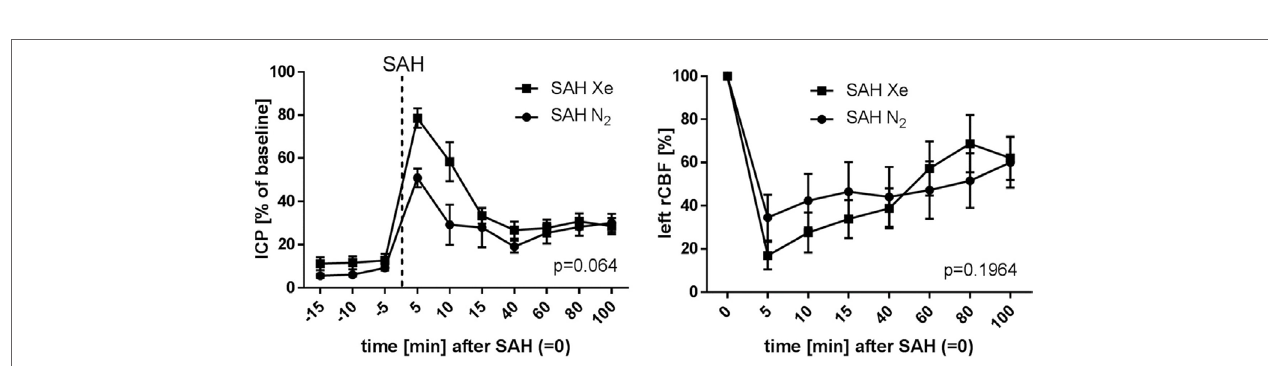
Figure 4 | Course of ICP and rCBF. Graphs for intracranial pressure (ICP) and left regional cerebral blood flow (rCBF) are presented as mean ± SD of percentages of baseline values; time = 0 min is defined as subarachnoid hemorrhage (SAH). The courses did not differ between the xenon and control group (repeated measures analysis of variance).